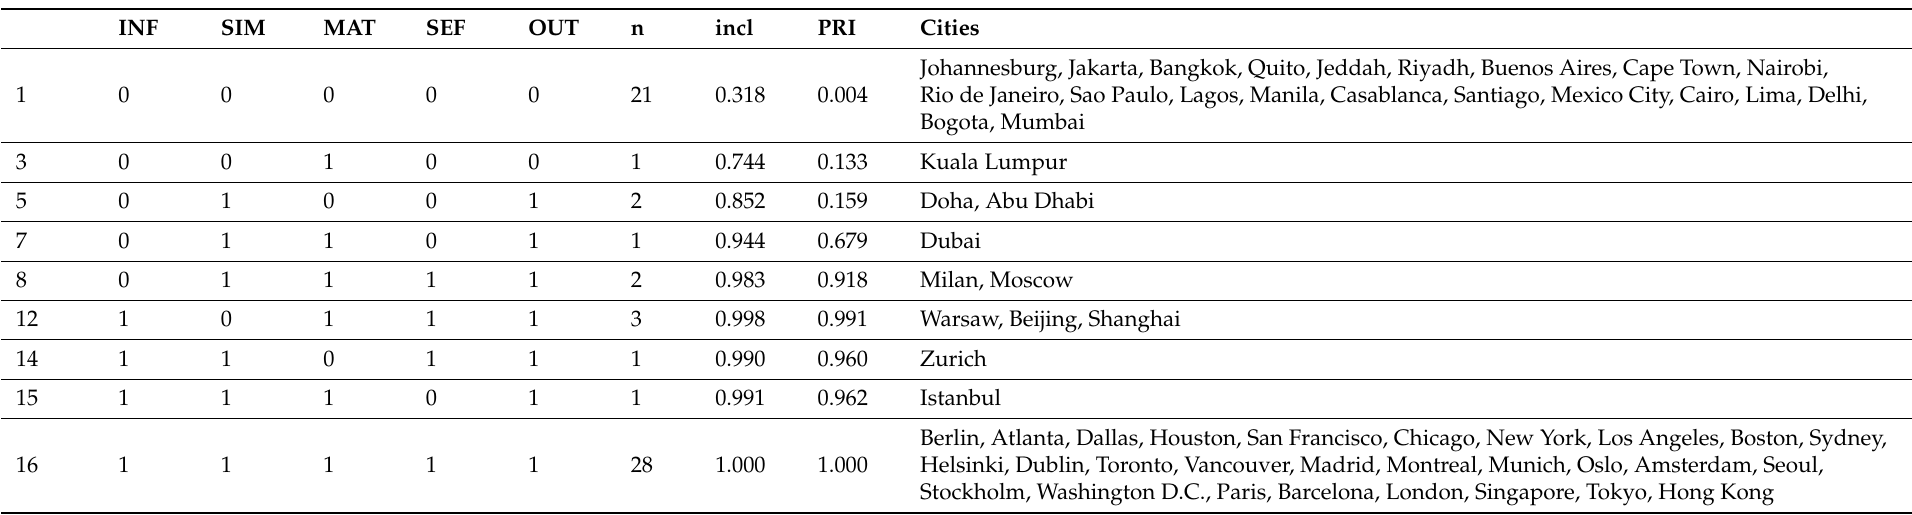
Table 2. Truth Table OVE